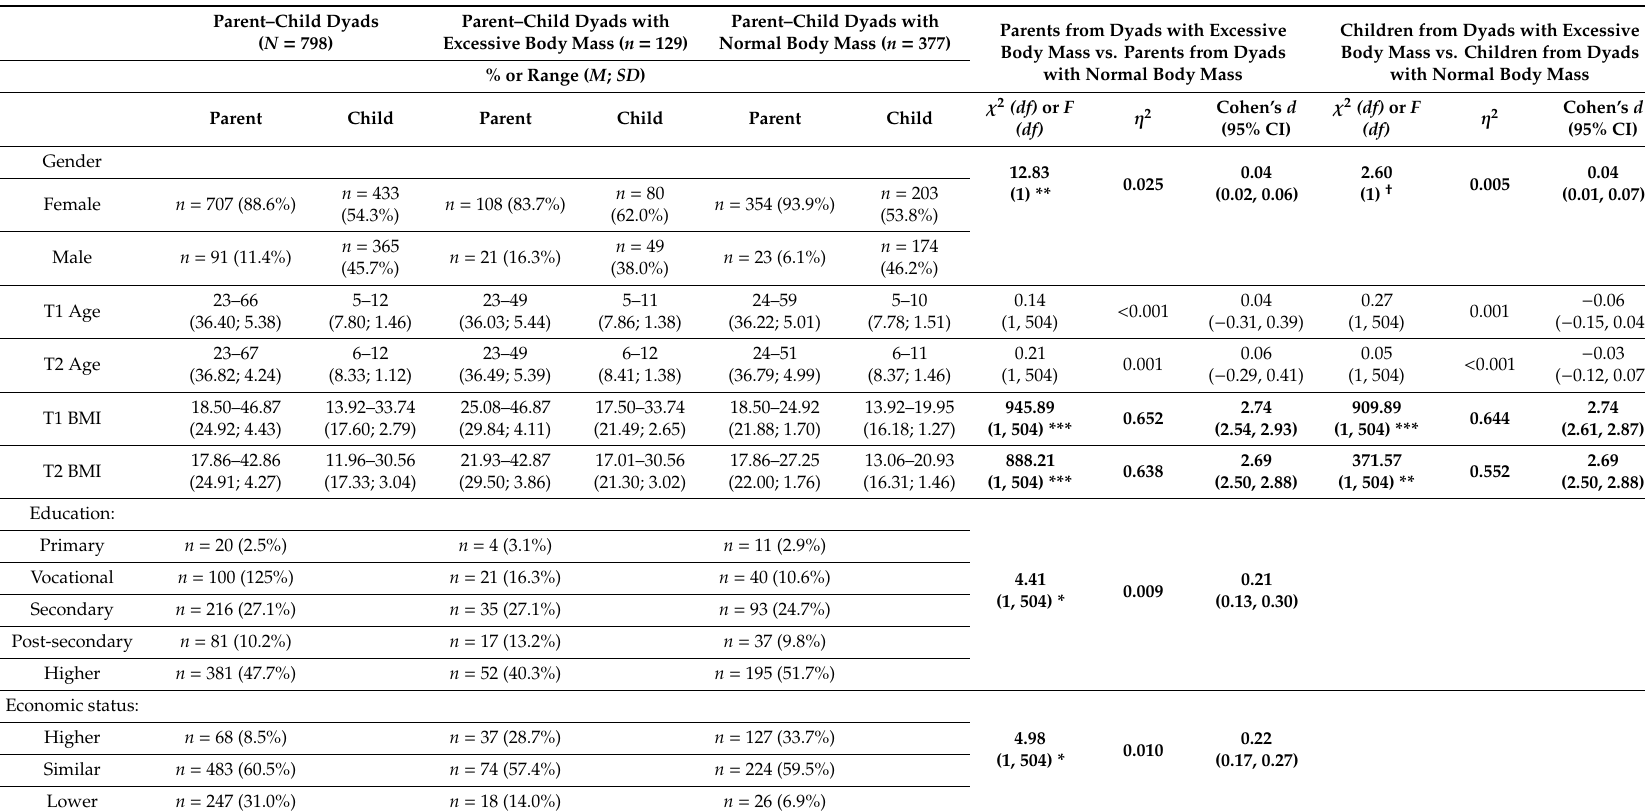
Table A1. Demographic and clinical characteristics of N = 798 parent–child dyads and the main analyzed sample ( N = 506 dyads) including, parent–child dyads with excessive body mass ( n = 129) and parent–child dyads with normal body mass ( n = 377).